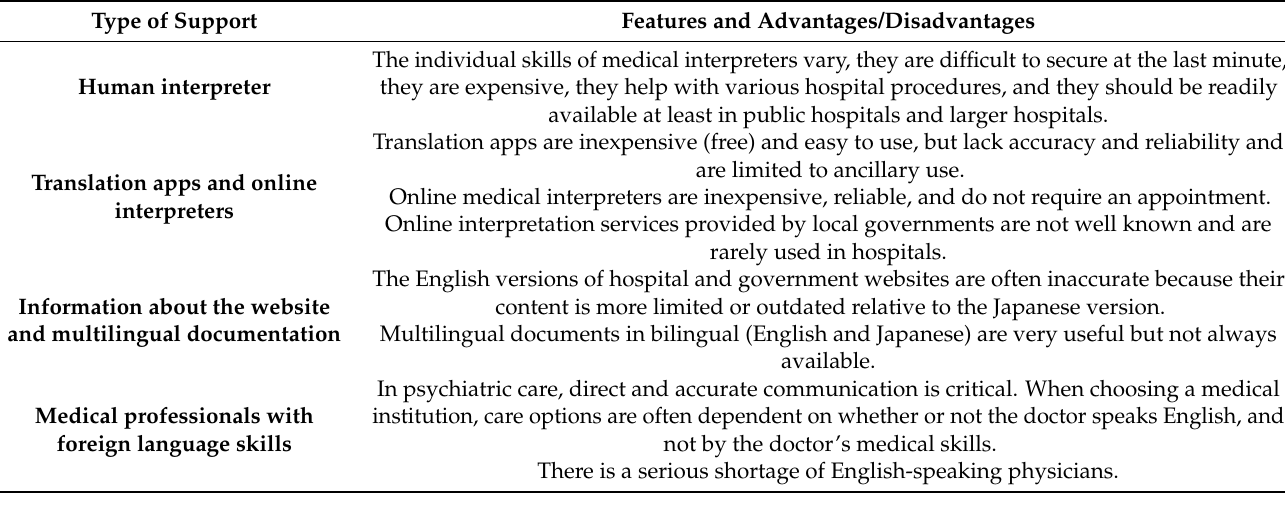
Table 4. Types of language support mentioned by participants and their advantages and